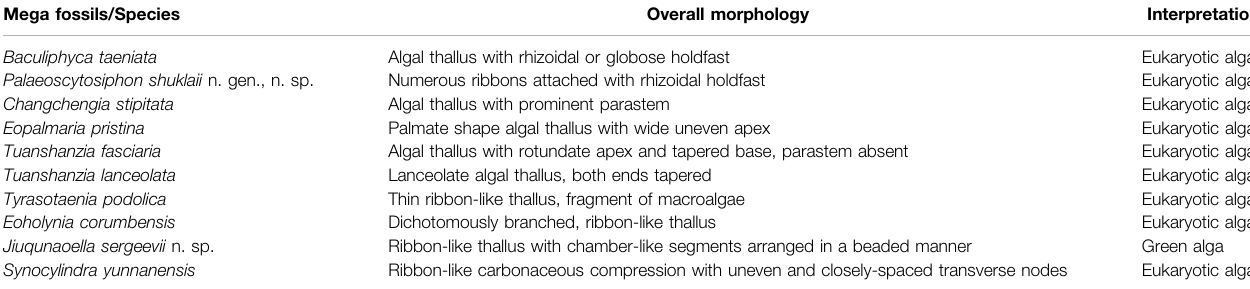
TABLE 2 | Megascopic carbonaceous macroalgae from the Saraipali and Chhuipali Formations of the Singhora Group. Mega